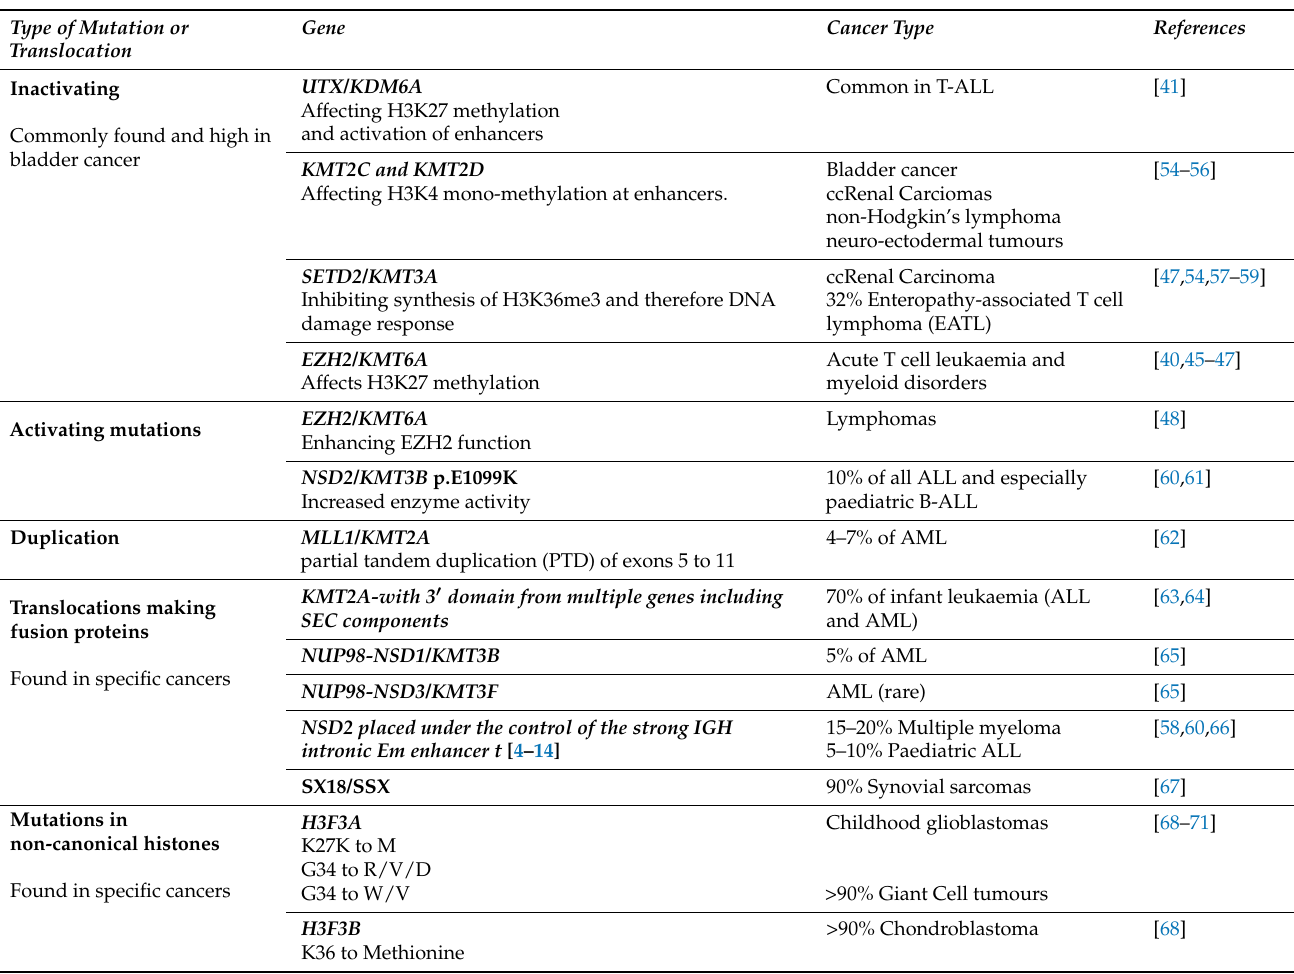
Table 1. Mutations and translocations of methylases and demethylases in